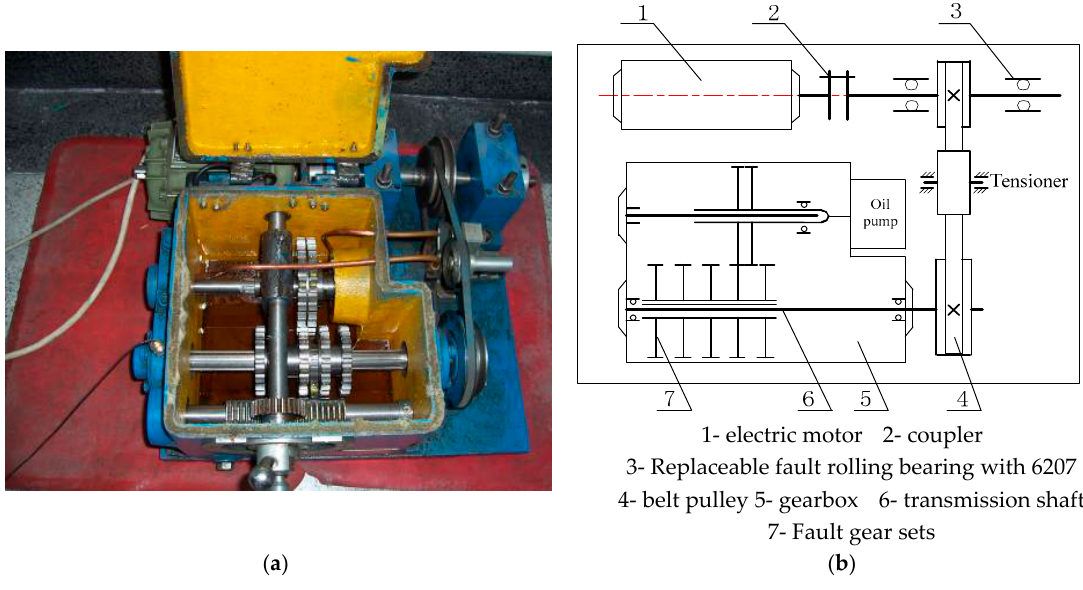
Figure 6. Fault experimental table of roll bearing. ( a ) The physical map of test rig; ( b ) The structure diagram of test rig.